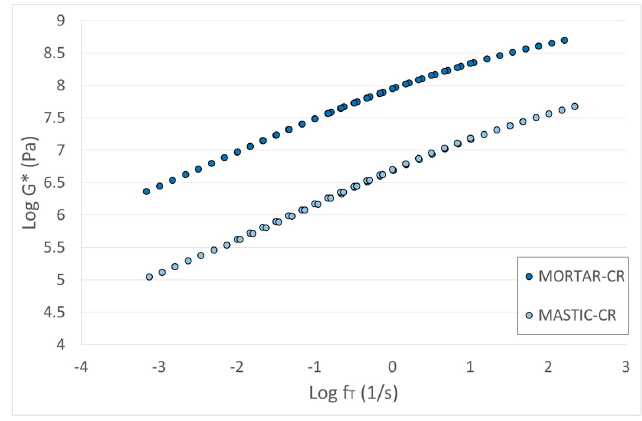
Figure 8. MORTAR-CR and MASTIC-CR master curves.